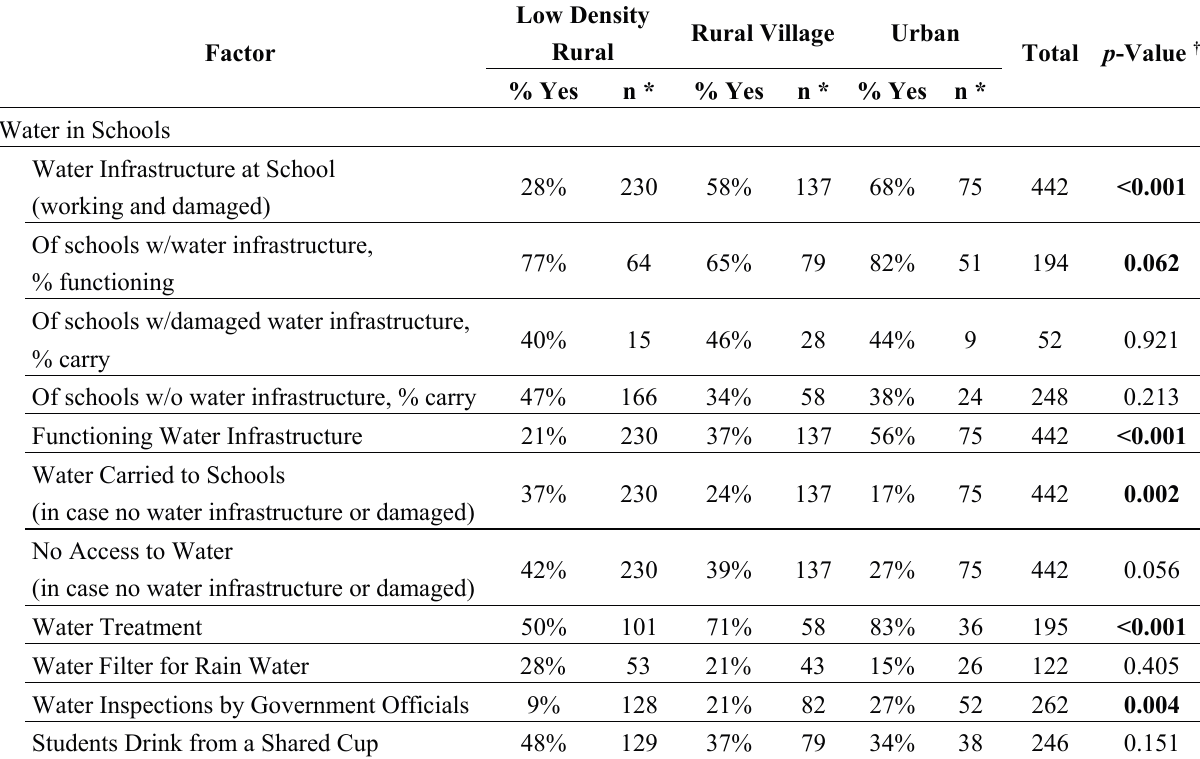
Table 3. Urban-rural patterns in select variables of wash in